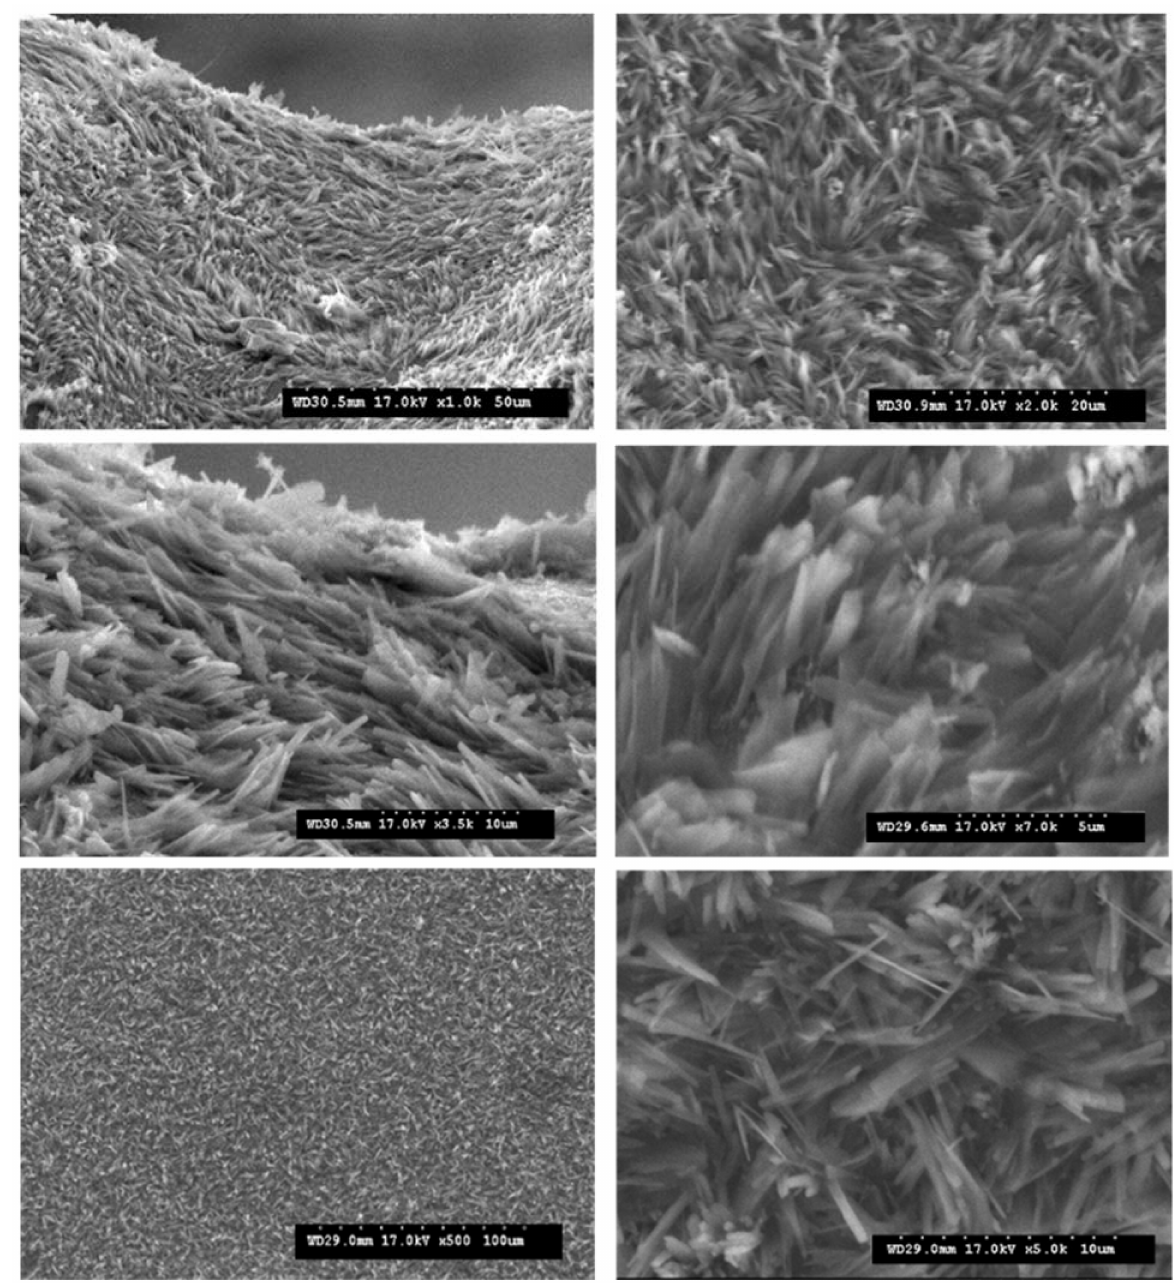
Figure 8. Carbon nanowhiskers. Variant X4 (RF gel impregnated in carbon felt after